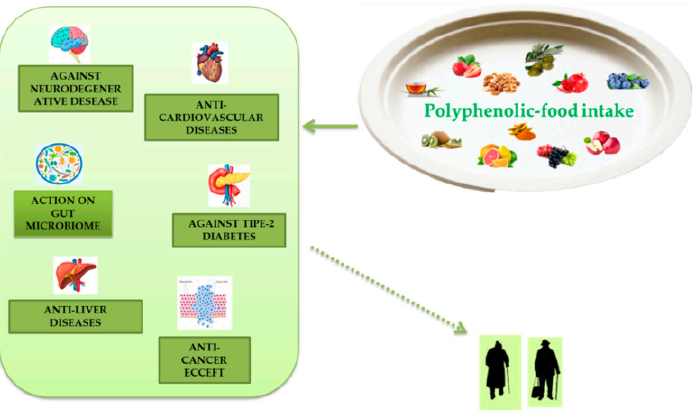
Figure 4. Polyphenolic-food can be useful to combat metabolic and degenerative diseases associated to